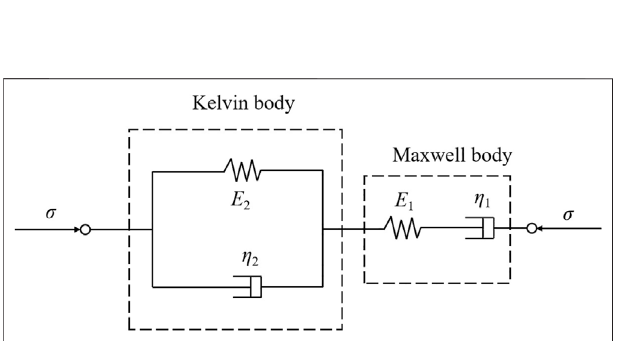
FIGURE 4 | Sketch of Burgers